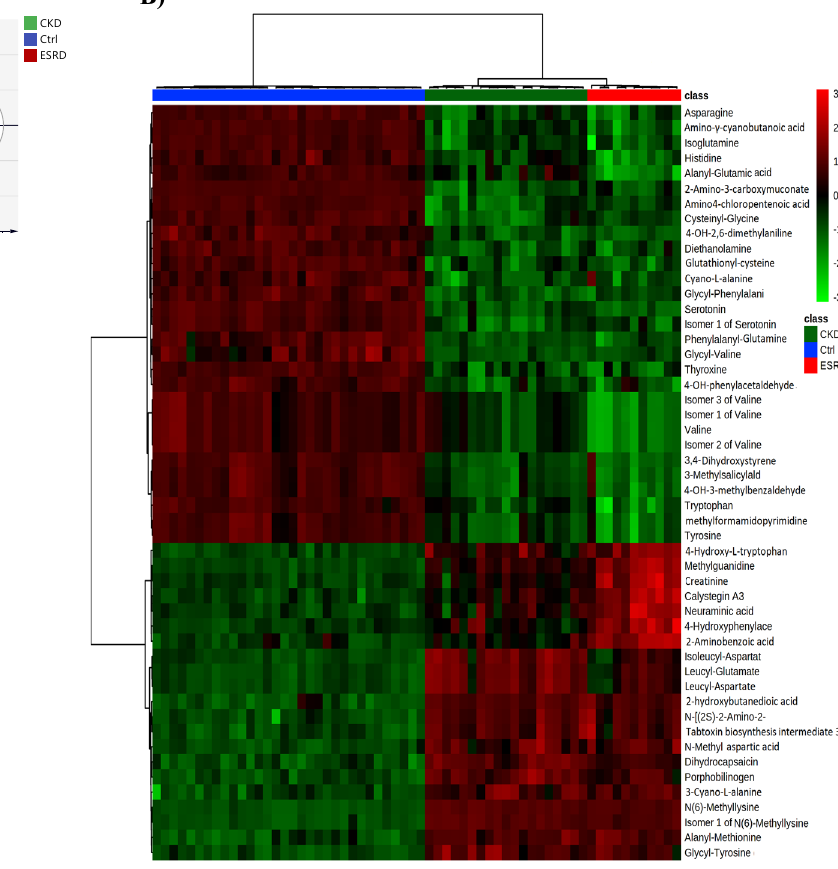
Figure 2. ( A ) PLS-DA scores plot (R2X: 0.43, R2Y:0.84, Q2 0.75) of the three study groups; controls (blue), ESRD (red) and CKD (green). ( B ) Hierarchal clustering (HAC) and heatmap analysis of the top 50 significantly altered metabolites between the three study groups; controls (blue), ESRD (red) and CKD (green). ESRD end- stage renal disease, CKD chronic kidney